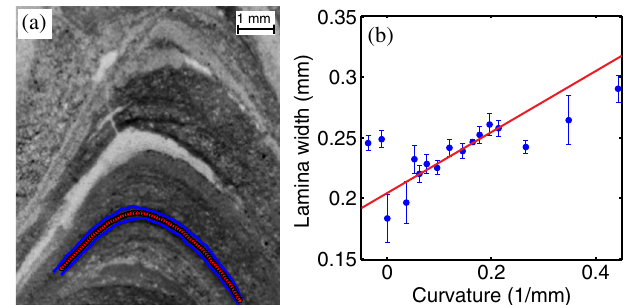
FIG. 3. The shape of stromatolite laminas records the stroma- tolite’s evolution in time. (a) A 2 : 9 (cid:1) 10 9 -yr-old conical stro- matolite from the Pongola Supergroup in South Africa cut vertically through the center. The transitions between light and dark laminas record the shape of the stromatolite at different points in time. The two solid blue curves represent the surface of the stromatolite at different times. This curve was measured by visually following the transition between a light lamina and a dark lamina. (b) The width of a lamina increases ( R 2 ¼ 0 : 57 , p < 10 (cid:2) 8 ) with curvature. Thus, the rate at which this stromato- lite grew is an increasing function of curvature, consistent with Eq. (15). The fit of the measured lamina width and curvature to a straight line gives an estimate of the thickness of the overlying microbial mat (cid:1) ¼ 1 : 2 (cid:8) 0 : 6 (cid:4) 1 mm . Two additional laminas from this sample are shown in the Supplemental Material. Additional curvature-thickness plots are shown in Fig. 5 and the Supplemental Material [41].